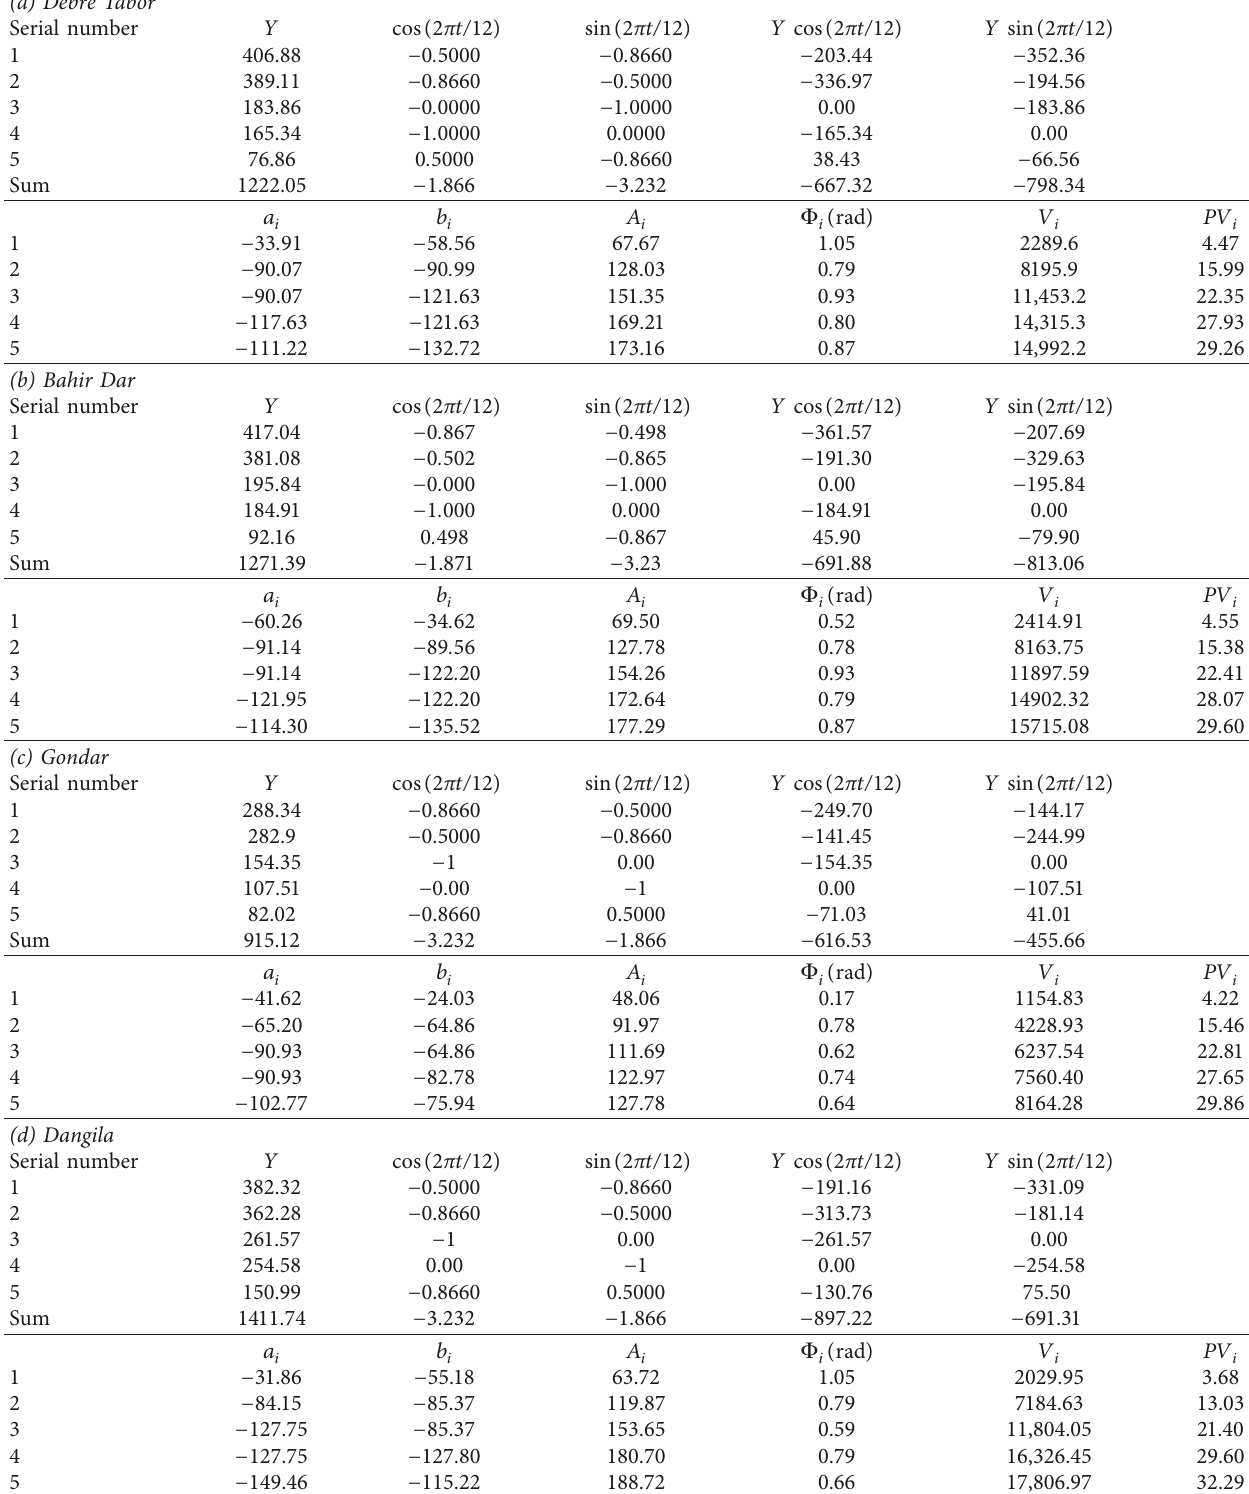
Table 2: Illustration of the mechanics of using (2), (3), and (5)–(13) to estimate the parameters of a fundamental harmonic for each station. (a) Debre